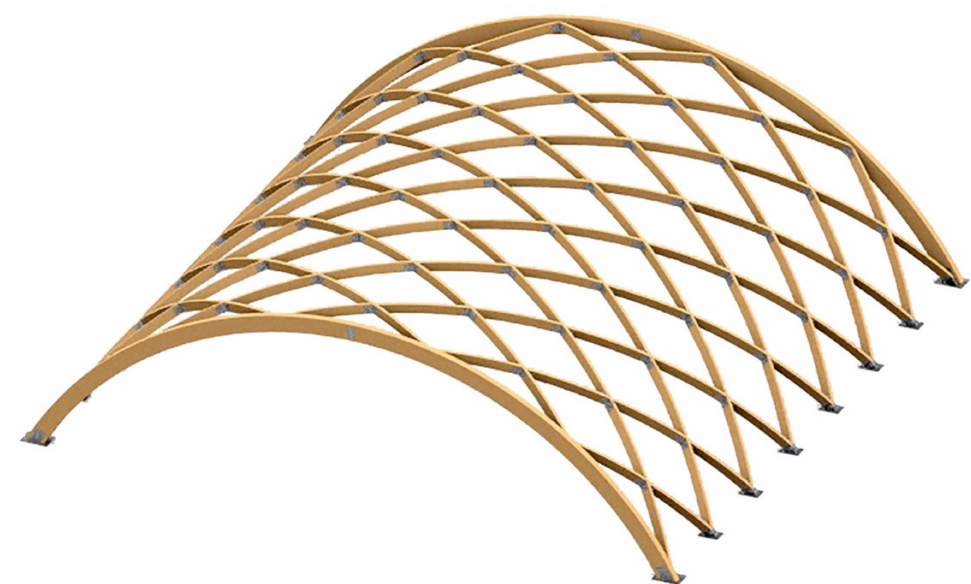
Figure 11. Three-dimensional model of the designed lamella vault.